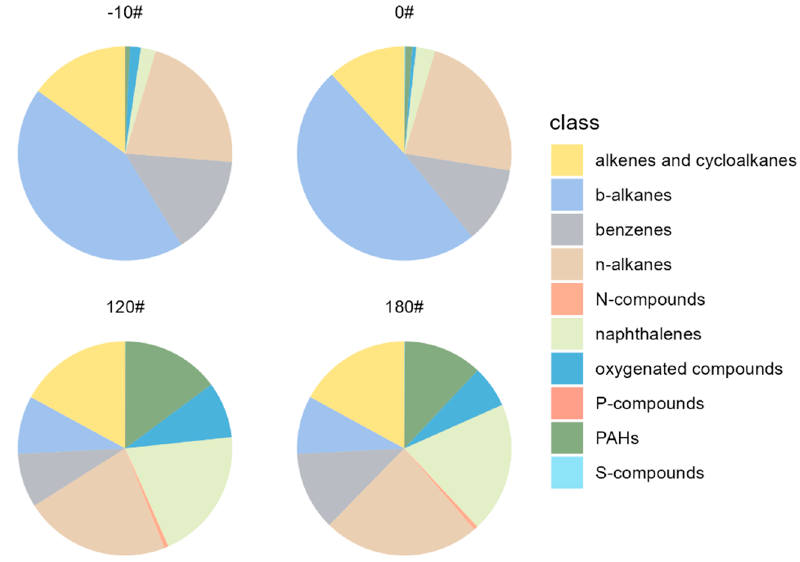
Figure 2. Chemical compositions of organic compounds in different types of fuel (-10#, 0#, 120#, and 180#).